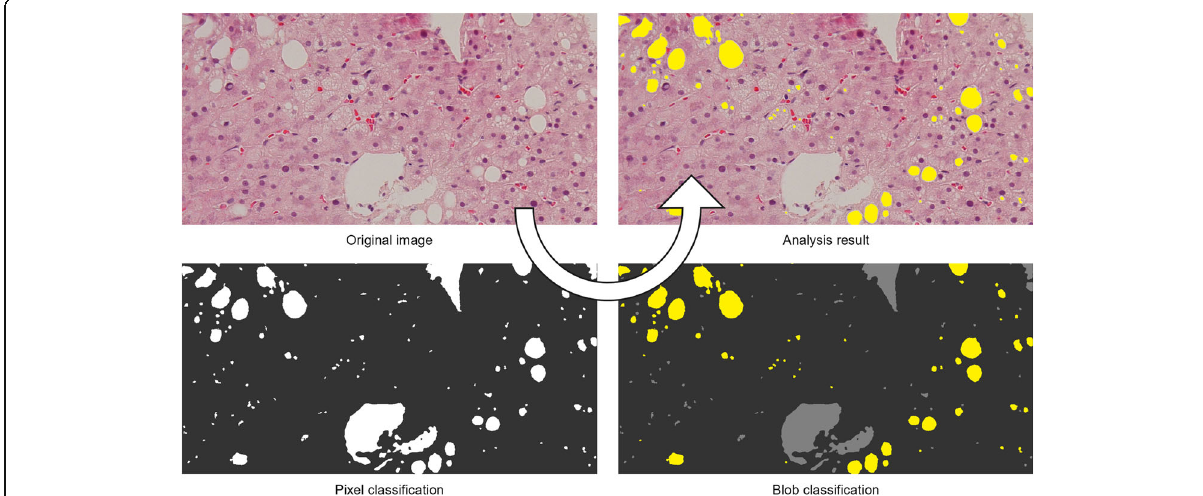
Fig. 3 Overview of the analysis framework. First, pixels are classified as foreground or background. Afterwards, blobs of foreground pixels are classified as fat or other empty